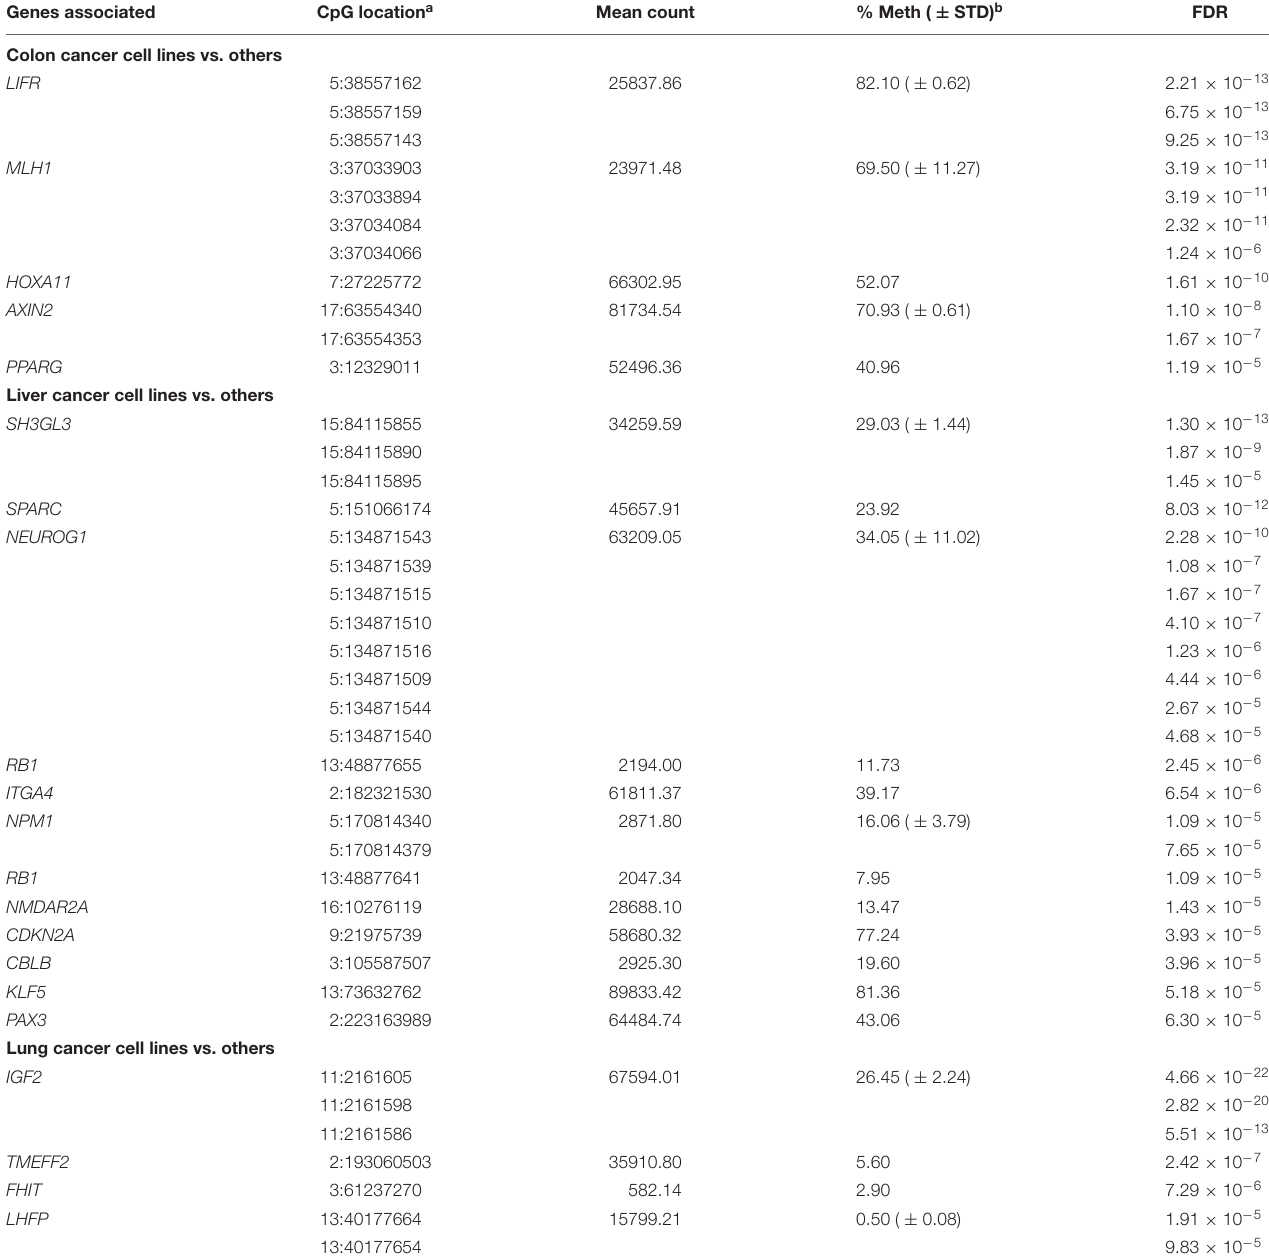
TABLE 1 | CpG sites differentially methylated among cancer cell groups. Genes associated CpG location a Mean count % Meth ( ± STD) b FDR Colon cancer cell lines vs.